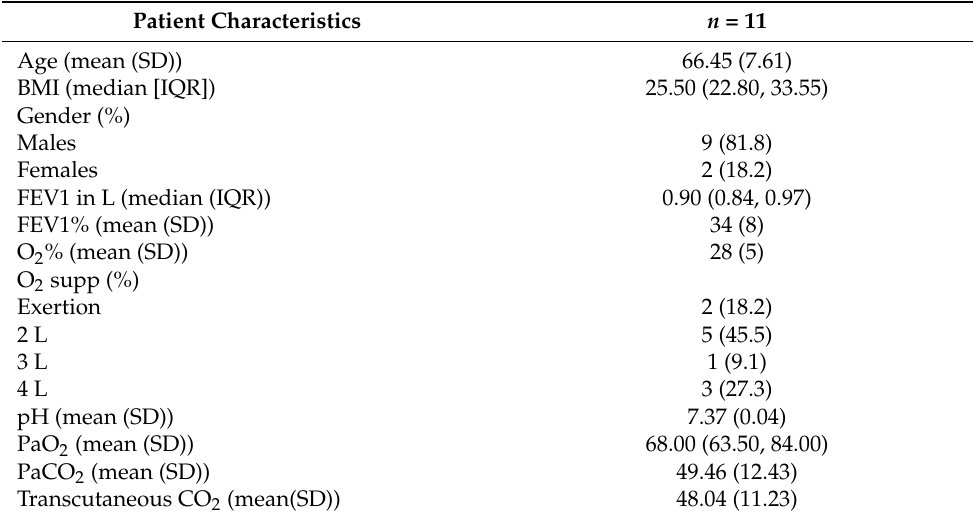
Table 1. Clinical characteristics of patients with severe COPD (FEV1 <